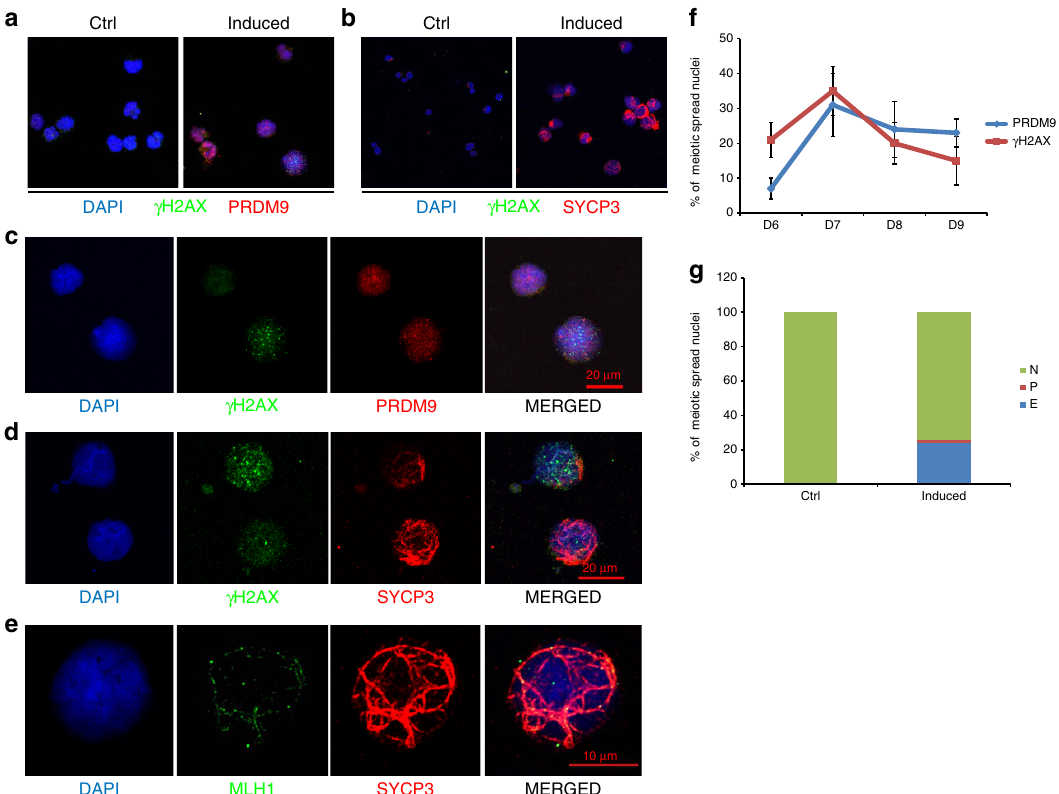
Figure 4 | Meiotic progressions in the differentiated hESCs. ( a ) Representative images of meiotic spreads and immunofluorescent staining of PRDM9 and g H2AX in control and induced hESCs. ( b ) Representative images of meiotic spreads and immunofluorescent staining of SYCP3 and g H2AX in control and induced hESCs. ( c ) Magnified image of the meiotic spreads and the immunofluorescent staining of PRDM9 and g H2AX in induced hESCs. Bar, 20 m m. ( d ) Magnified image of the meiotic spreads and immunofluorescent staining of SYCP3 and g H2AX in induced hESCs. Bar, 20 m m. ( e ) Magnified image of the meiotic spreads and immunofluorescent staining of SYCP3 and MLH1 in induced hESCs. Bar, 10 m m. ( f ) Percentages of PRDM9- and g H2AX-positive nuclei during in vitro -induced meiosis from day 6 to day 9, n 4 200 meiotic nuclei at each time point, error bar indicates s.d. ( g ) Percentages of nuclei with no SYCP3 (N), punctate SYCP3 (P) or elongated SYCP3 (E) during in vitro -induced meiosis at day 7, n 4 200 meiotic nuclei. At least three independent experiments were conducted for each set of meiotic spreads and immunostainings described